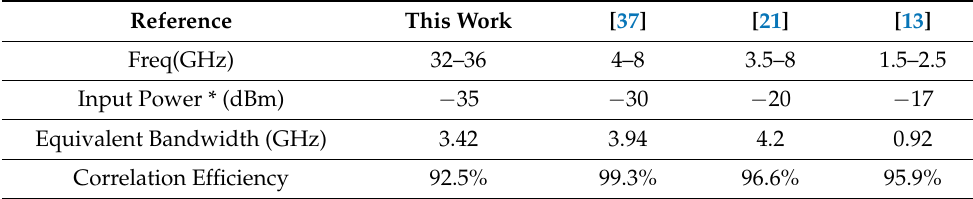
Table 1. Comparison of the analog